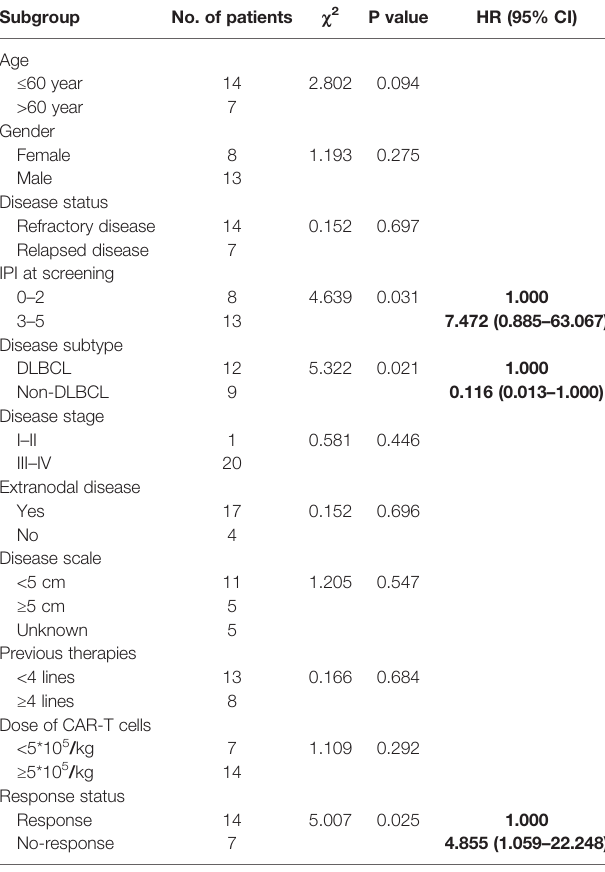
TABLE 2 | Univariate analysis of overall survival